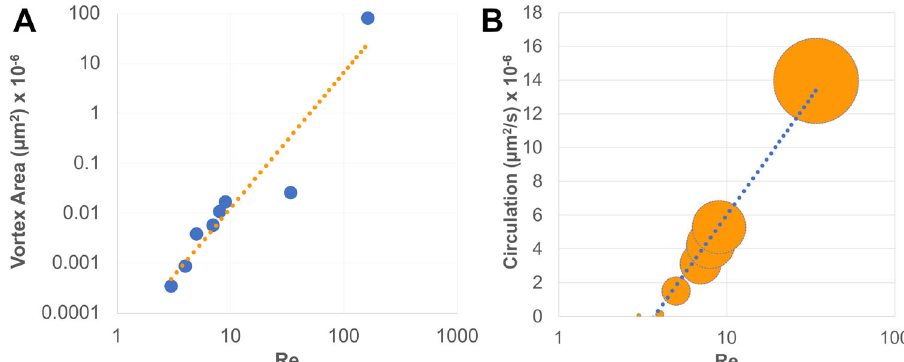
Fig. 2 Vortex characteristics. a Vortex area increases as ≈ Re 2.7 (dashed line, R 2 = 0.9057). b Circulation correlates with Re; the size of the marker point represents the minimum and maximum circulation calculated for the vortex developing at the tip of the valve and the dotted line represents a logarithmic fi t ( R 2 = 0.9788).